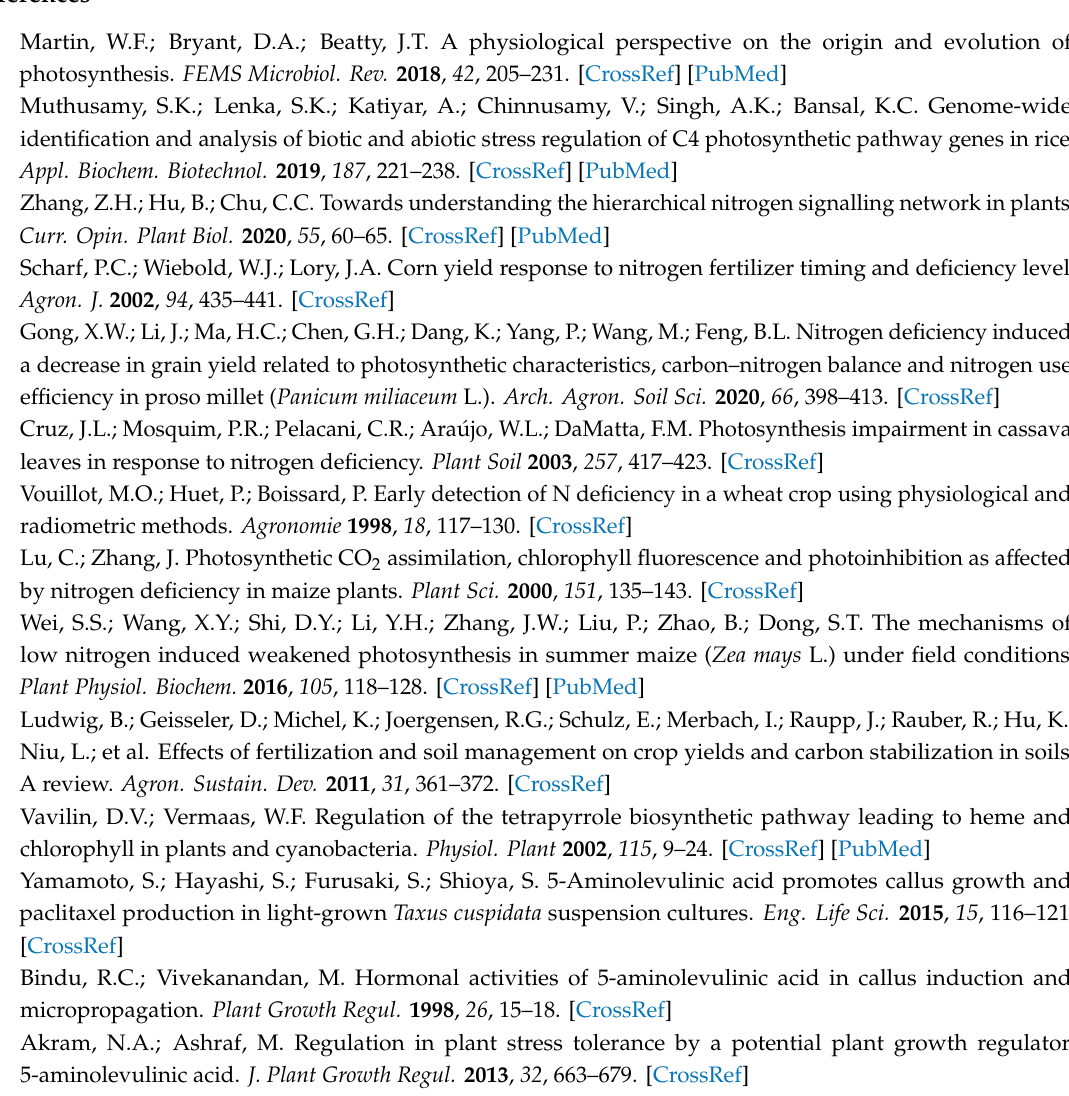
Figure S1: Changes in (a) the prompt fluorescence (PF) and (b) the variable fluorescence curves ( ∆ V) of canola leaves under low, middle, and high nitrogen levels. Table S1: Correlation analysis for leaf Chl content, gas exchange, and the considered PF and MR parameters. Table S2: The mean ± SE and statistical tests for the JIP test parameters of each treatment